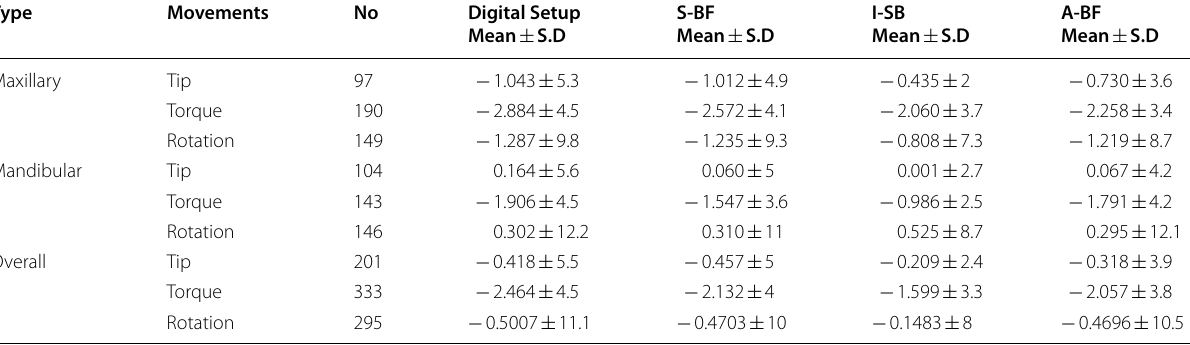
Data was expressed using Mean SD ± Table 3 Intra Class Correlation Coefficient for different movements among the three software packages, in comparison to Digital Setup